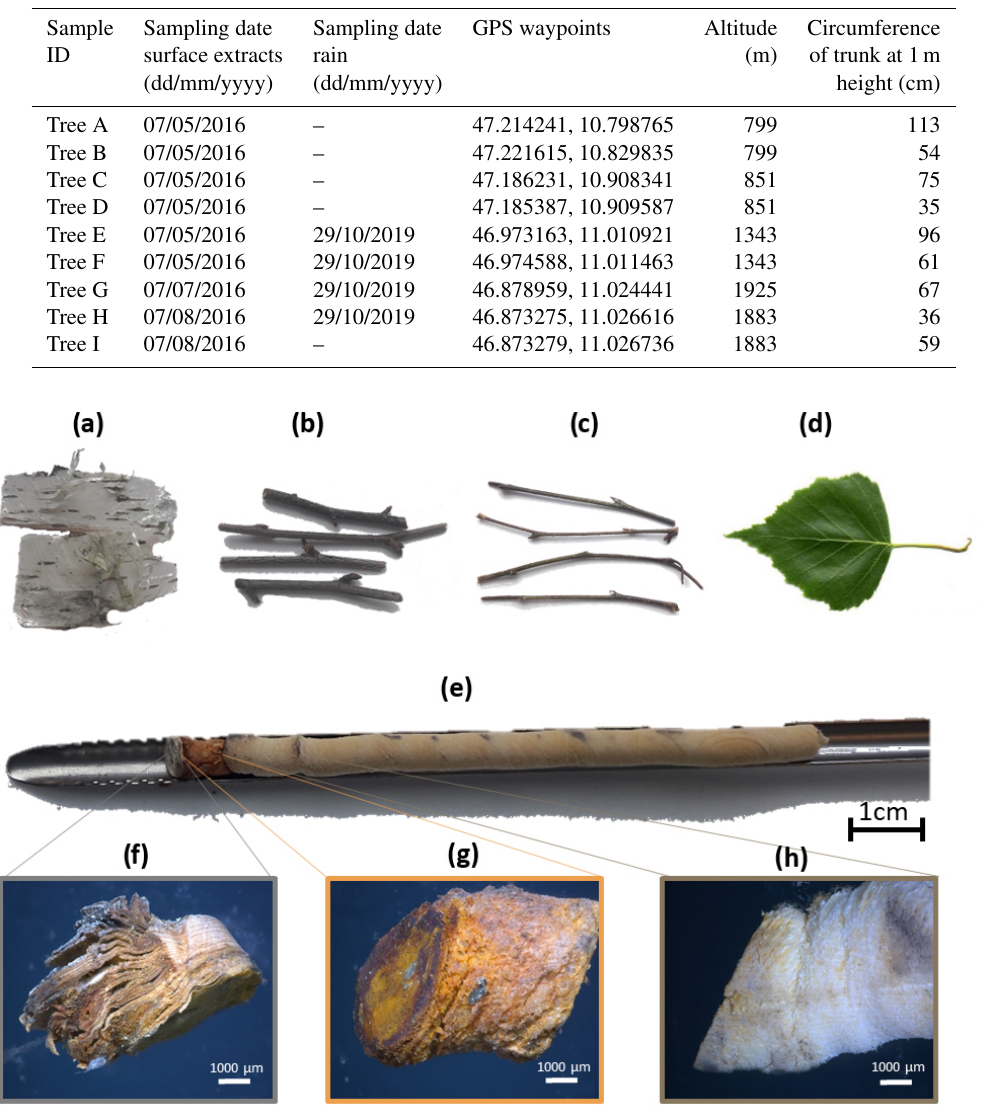
Table 1. Information for the nine sampled birches in Tyrol, Austria. Cores and samples for surface extraction experiments were taken in summer 2016. Rain samples were collected in October 2019 underneath Tree E, F, G and H.